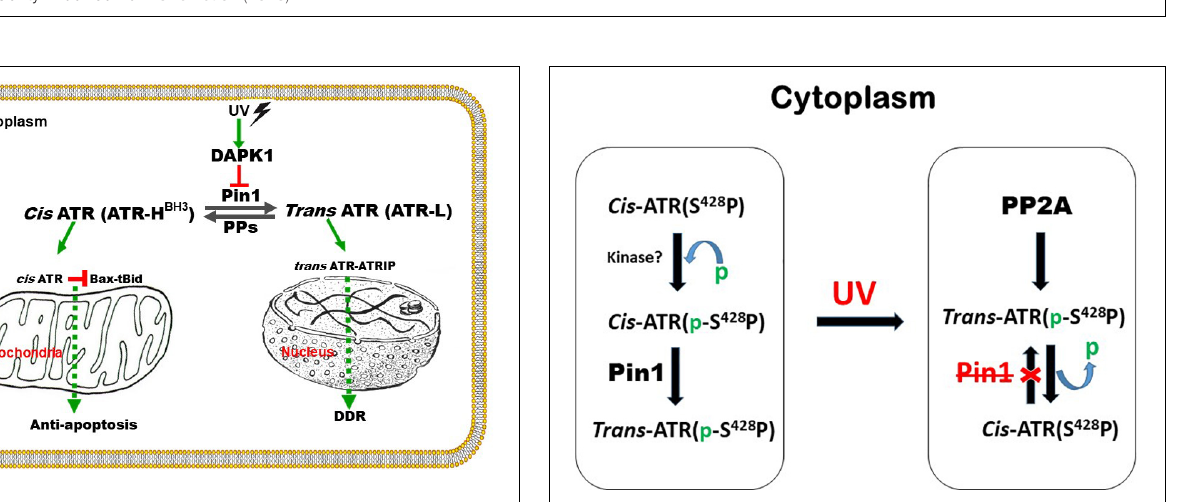
anti-apoptotic role ( Figure 3 ). In addition, cells in which